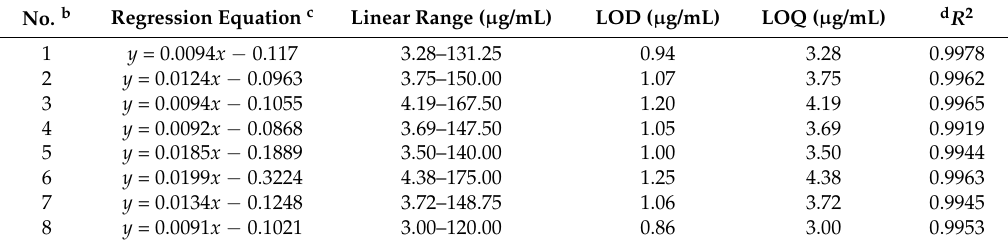
Table 1. Linearity of CZE (Capillary Zone Electrophoresis) method of different analytes 1 – 8 a .